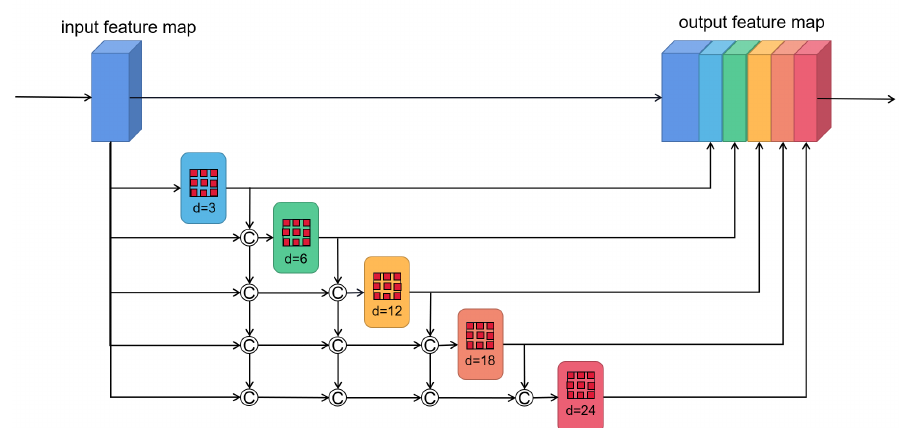
Figure 2. The structure of densely connected atrous convolution. The output of each dilated con- volutional layer is concatenated with input feature maps, and then feed into the next dilated